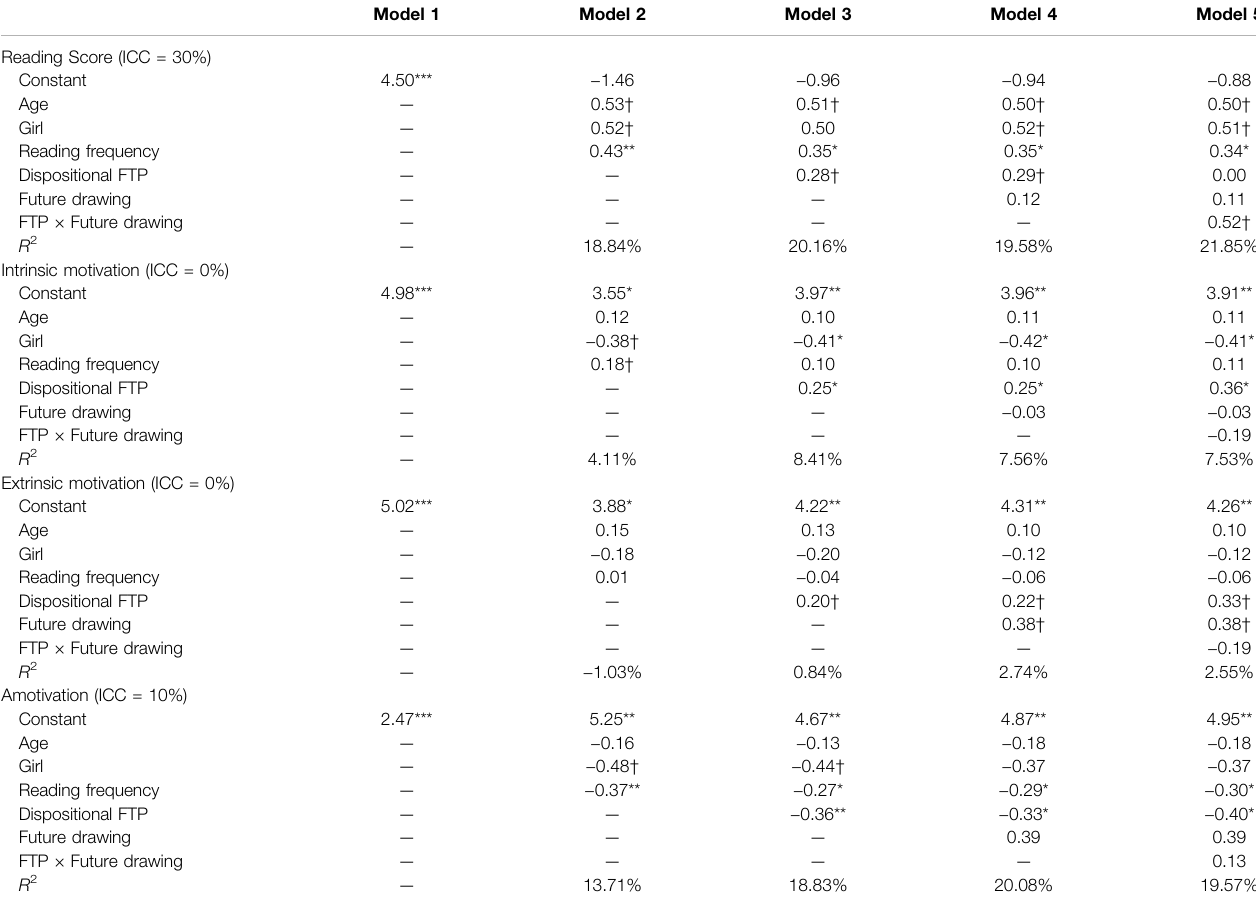
TABLE 4 | Regression coef fi cients of the multilevel linear models (N (cid:1)